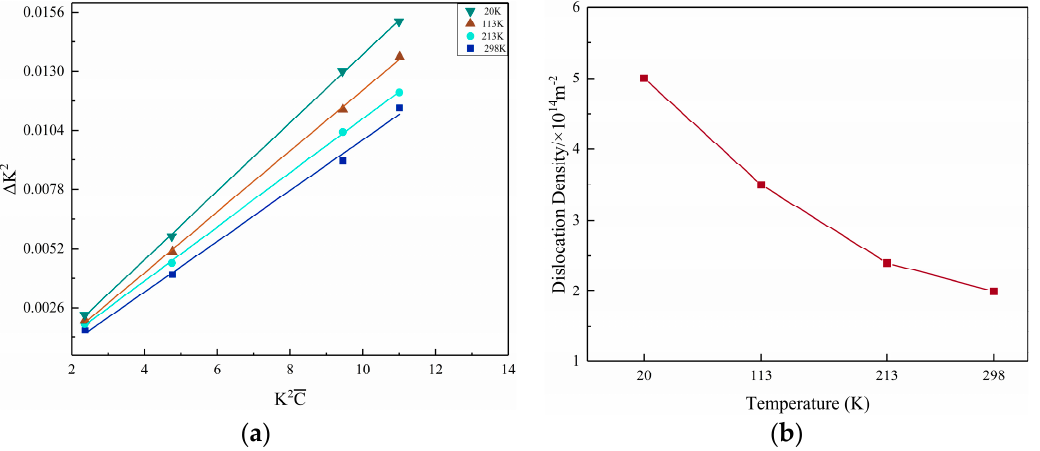
Figure 10. Grain size of fractured samples at different temperatures: ( a ) 298 K; ( b ) 213 K; ( c ) 113 K; ( d ) 20 K.